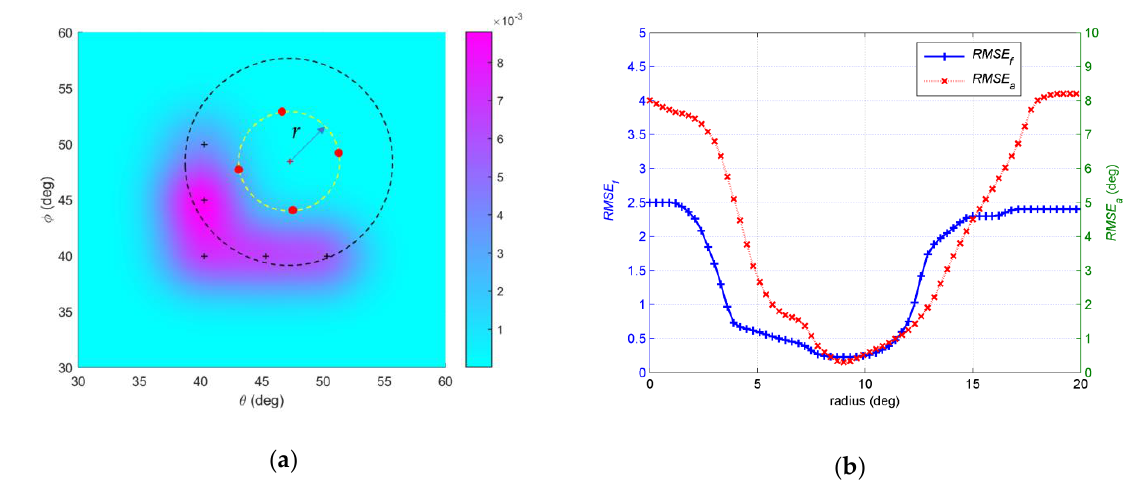
Figure 9. ( a ) Description of initial positions of Gaussian components and circles r equals 8.5°; ( b ) RMSE a and RMSE f estimated by different r with assumptive nominal angle (47°, 48.5°) .